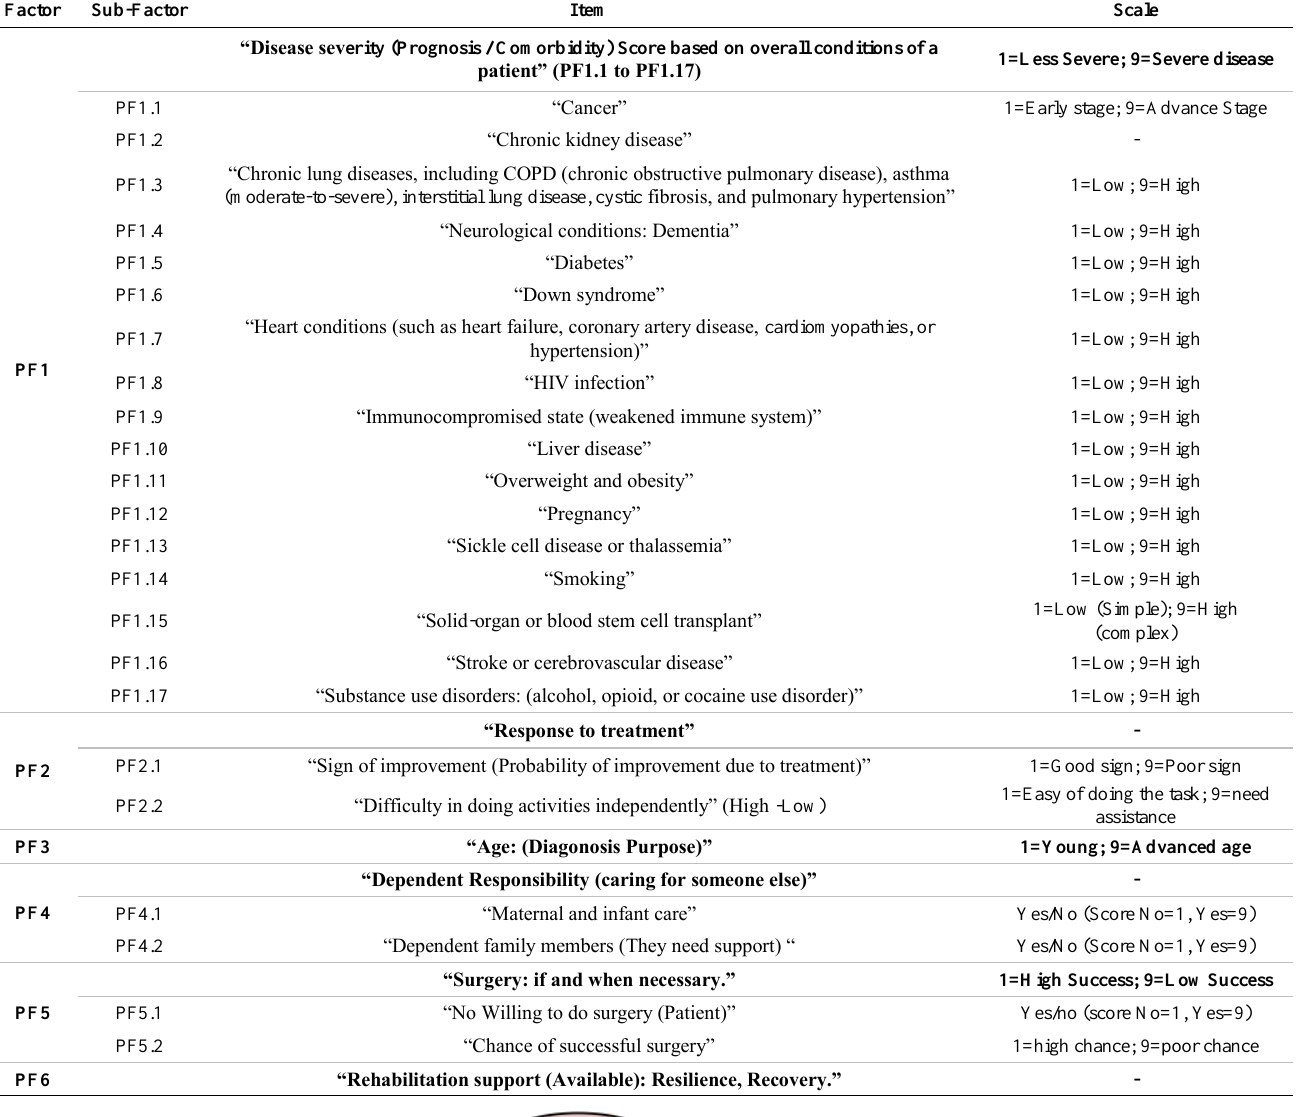
Table 1. Comorbidity: Descriptions and Operationalization of critical criteria to determine patient priority